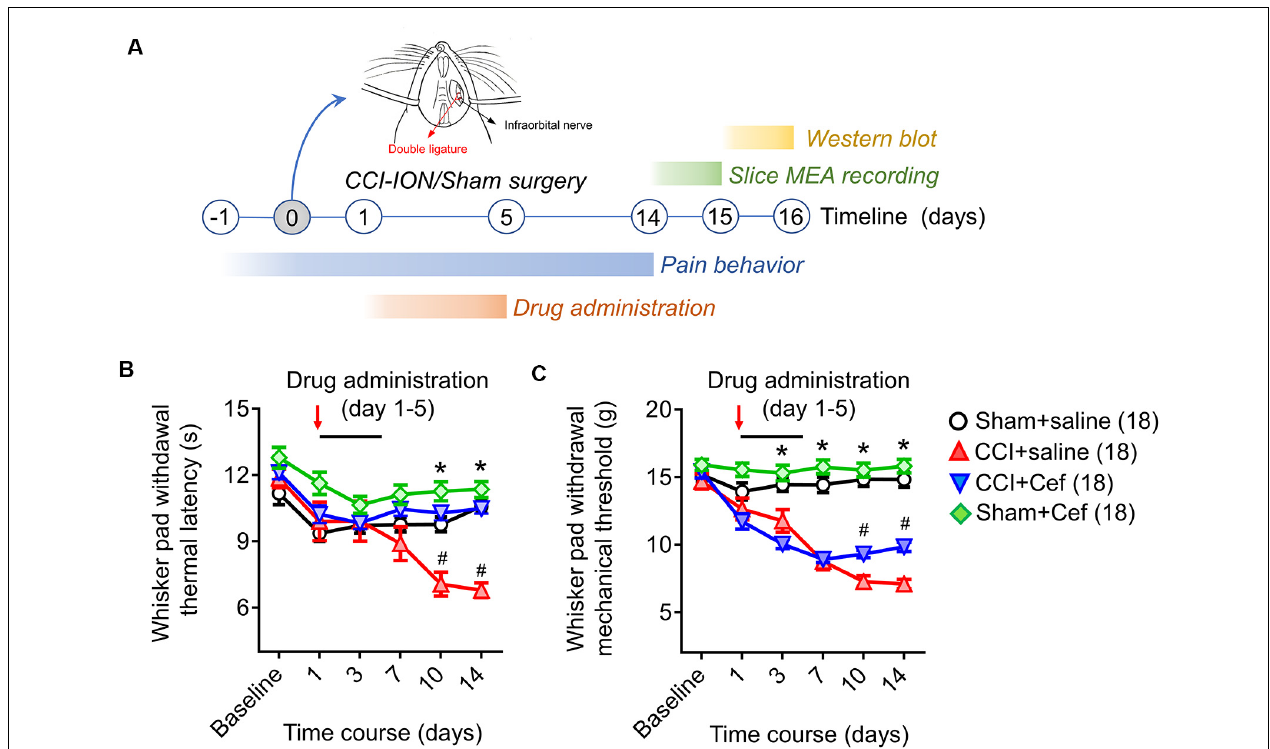
FIGURE 1 | Timeline of the experimental design and procedures, as well as the effects of repeated systemic administration of ceftriaxone (Cef) on CCI-ION-induced pain hypersensitivity. (A) Timeline of the experimental design and procedures (for details see “Materials and Methods” section in the text). (B,C) Changes in whisker pad withdrawal thermal latency and mechanical threshold in rats with Sham + saline ( n = 18), CCI-saline ( n = 18), CCI-Cef ( n = 18) and Sham + Cef ( n = 18). Arrows indicate the start of the drug administration. Data are presented as mean ± SEM. * p < 0.05, CCI + saline vs. Sham + saline; # p < 0.05, CCI + Cef vs. CCI + saline. CCI-ION, chronic constriction injury of infraorbital nerve; MEA, multi-electrode array.